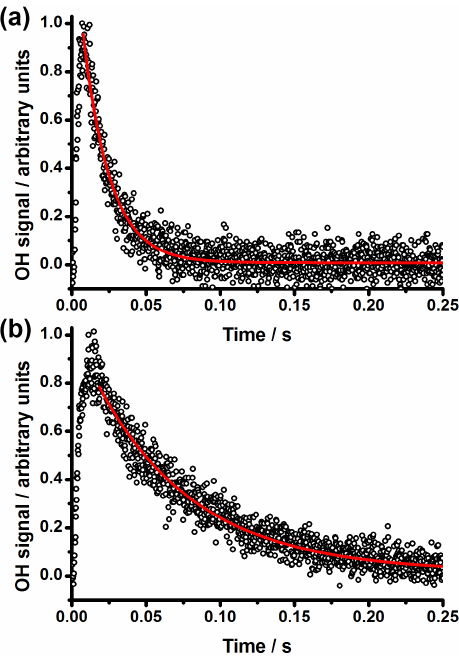
Figure 3. Typical OH time profiles following photolysis of ambient air (mixed with a small flow of N 2 / O 2 / O 3 / H 2 O) observed dur- ing the Clean Air for London (ClearfLo) campaign (black points) with fits of Eq. (5) (red lines) to the LIF data to determine k (cid:48) for data recorded (a) during a polluted period on 25 July 2012 = (46.6 ± 3.2)s − 1 ) and (b) during a cleaner period on 7 Au- ( k (cid:48) OH = (13.9 ± 0.9)s − 1 ) . Time zero is defined as the gust 2012 ( k (cid:48) OH time at which photolysis occurs. Decays represent data co-added throughout 5min